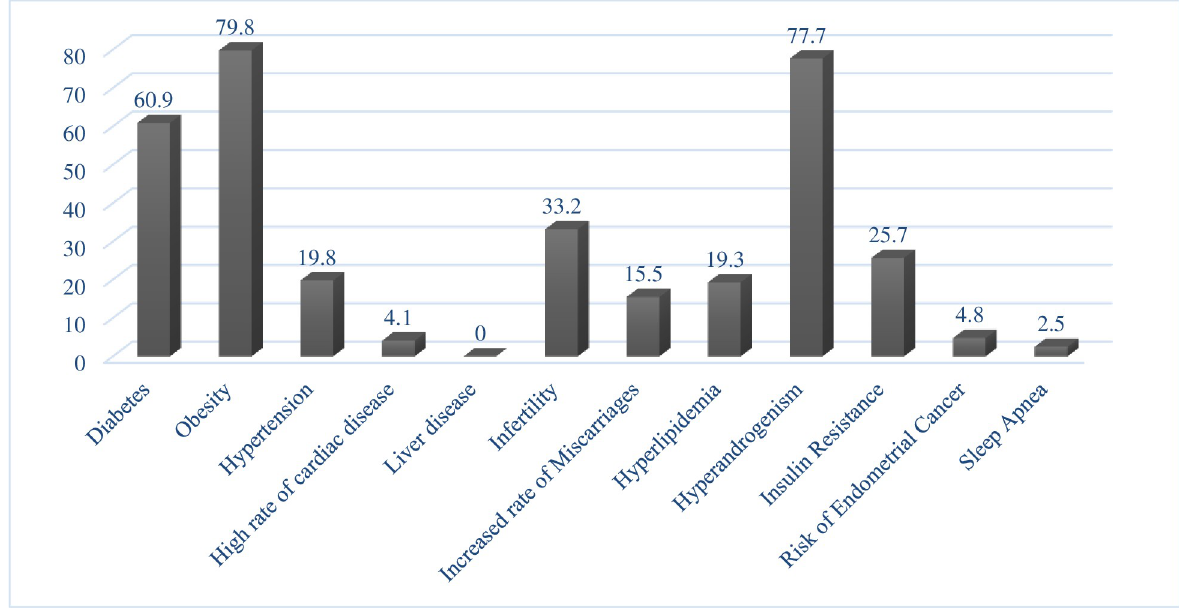
Fig 1. Bar graph showing the percentage of complications among patients with polycystic ovary syndrome.